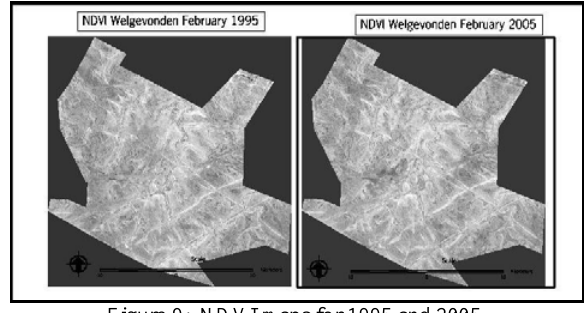
Figure 9: NDVI maps for 1995 and